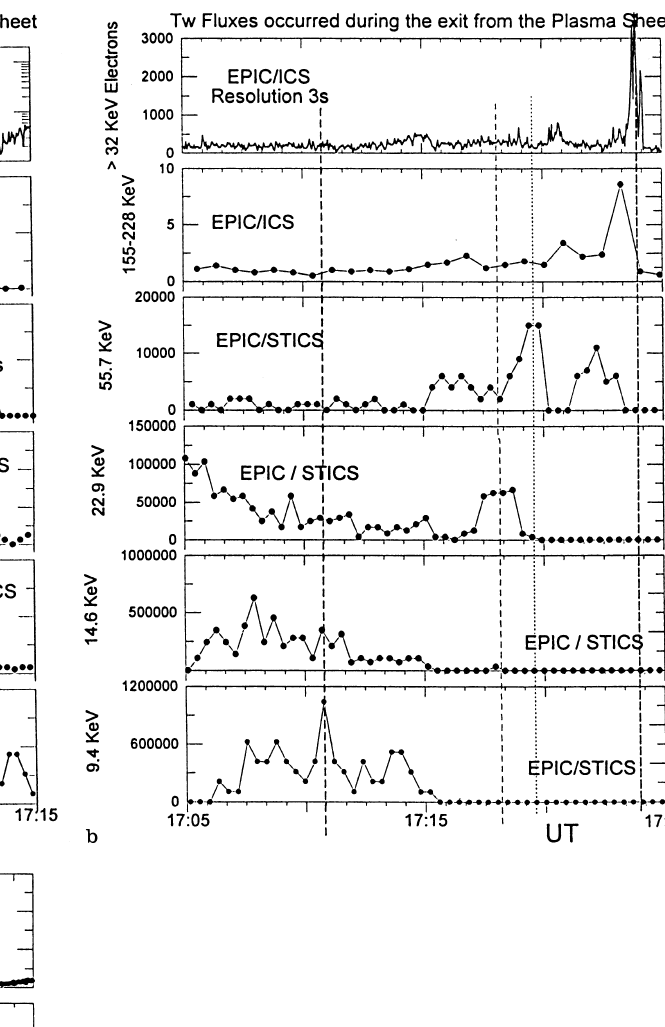
Fig. 4.a. We zoom in on the first GEOTAIL entry interval into the plasma sheet (see Fig. 2). All the panels show the tailward (dominant) di(cid:128)erential fluxes. The top panel gives the >32-keV electrons with resolution 3 s from EPIC/ICS. The second panel gives the 155–228- keV flux of protons with resolution 48 s from EPIC/ICS. The next panels show the 55.7, 22.9, 14.6, and 9.4-keV fluxes of protons with resolution 24 s obtained via the EPIC/STICS sensor. The systematic displacement of peak fluxes (i.e., the normal velocity dispersion e(cid:128)ect) is apparent. b . Format is the same as a. The fluxes show systematic reverse velocity dispersion as we zoomed in on the first exit interval from the plasma sheet (see Fig. 2). c From top to bottom spin- averaged di(cid:128)erential fluxes of >32-keV electrons (resolution 3 s), 187–222-keV of the CNO group (resolution 6 s), 58–77-kev protons (resolution 6 s), 194–281-keV alphas (resolution 48 s), 77–107-keV protons (resolution 96 s), 70–96-keV alphas (resolution 6 s). The di(cid:128)erent delay times of peak fluxes are due to a velocity filter e(cid:128)ect and reflect the spatial structure of the